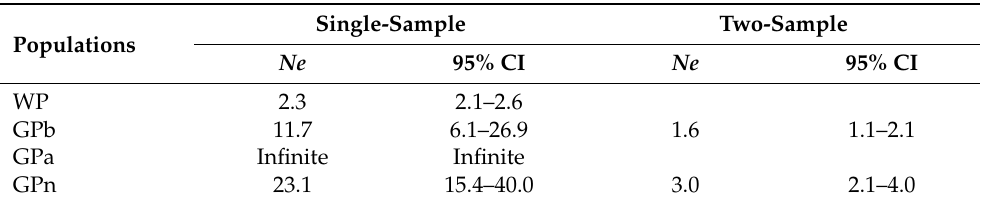
Table 4. The effective population size ( Ne ) of N. shimadai in northern Taiwan estimated from linkage disequilibrium under random mating with allele frequency ≥ 0.02 a . Populations